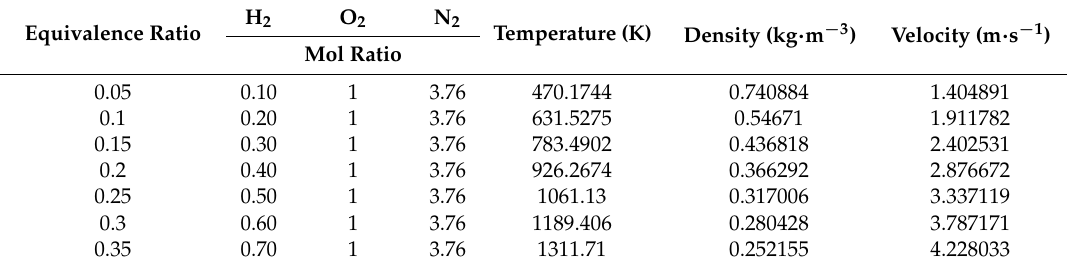
Table 1. Chemical equilibrium calculation.